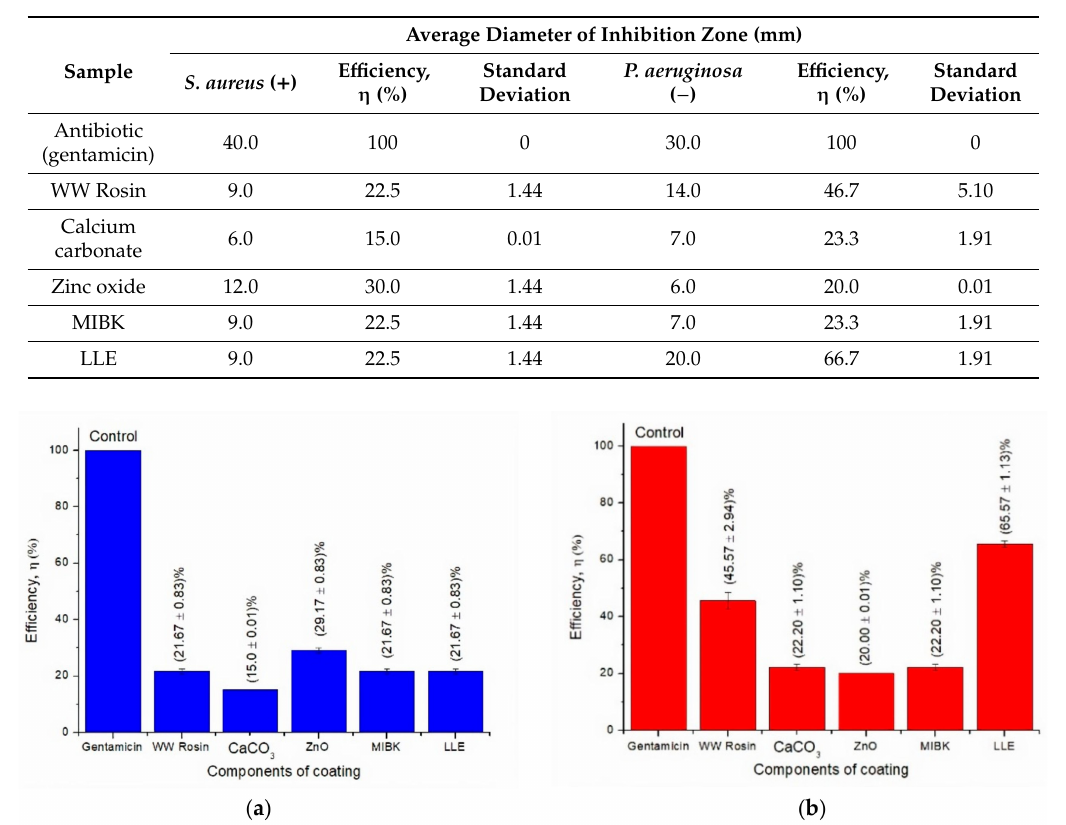
Figure10. Inhibitione ffi ciencyofthecoatingcomponentsagainstthe( a ) S.aureus ( + )and( b ) P.aeruginosa ( − )